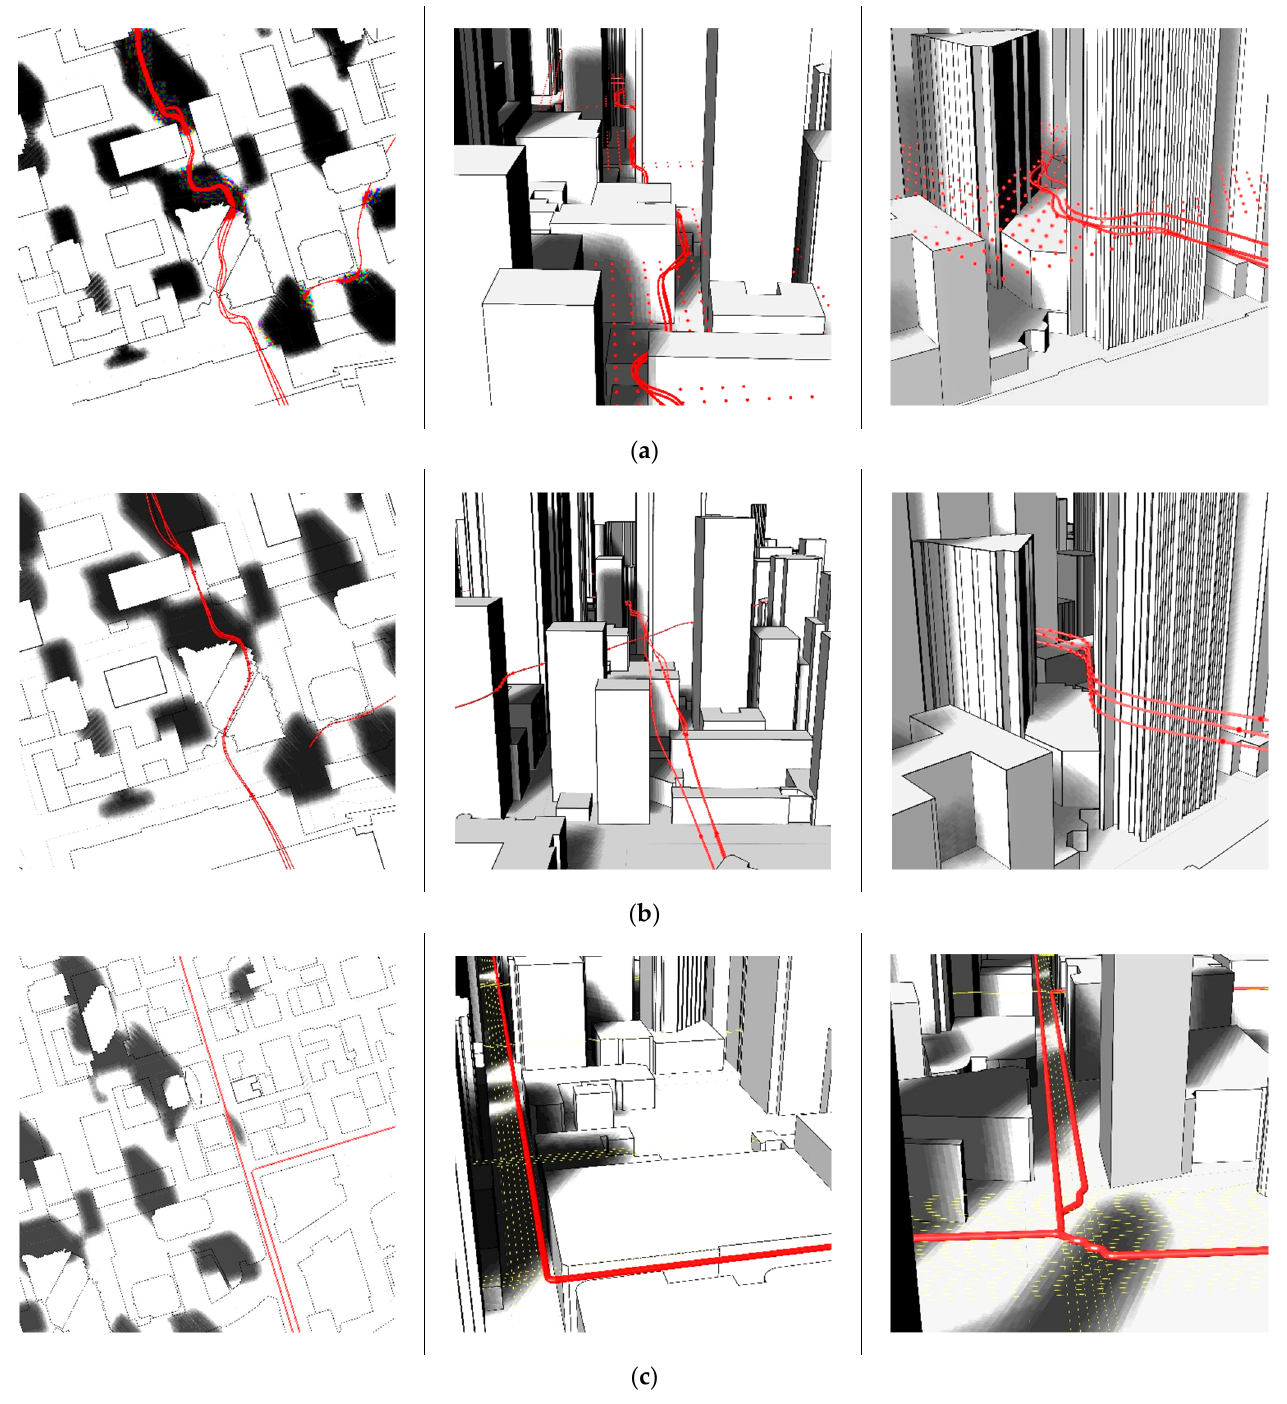
Figure 11. Zoomed in trajectory solutions visualizations comparison. ( a ) Dijkstra Algorithm; ( b ) A*Modified RRT Algorithm; ( c ) Skyroutes.